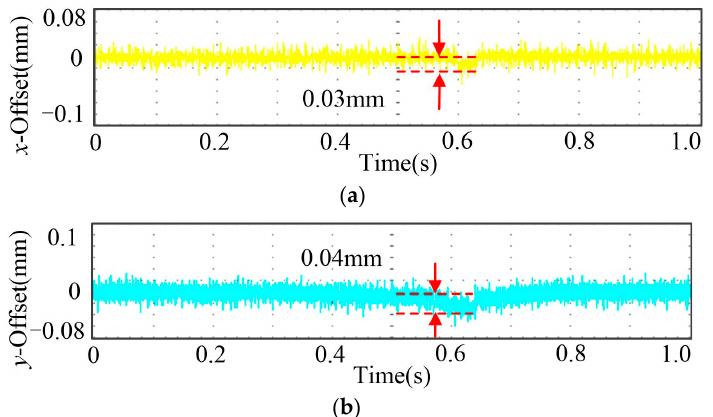
Figure 16. Experimental results in turning experiment. ( a ) Rotor offset in x direction. ( b ) Rotor offset in y direction.